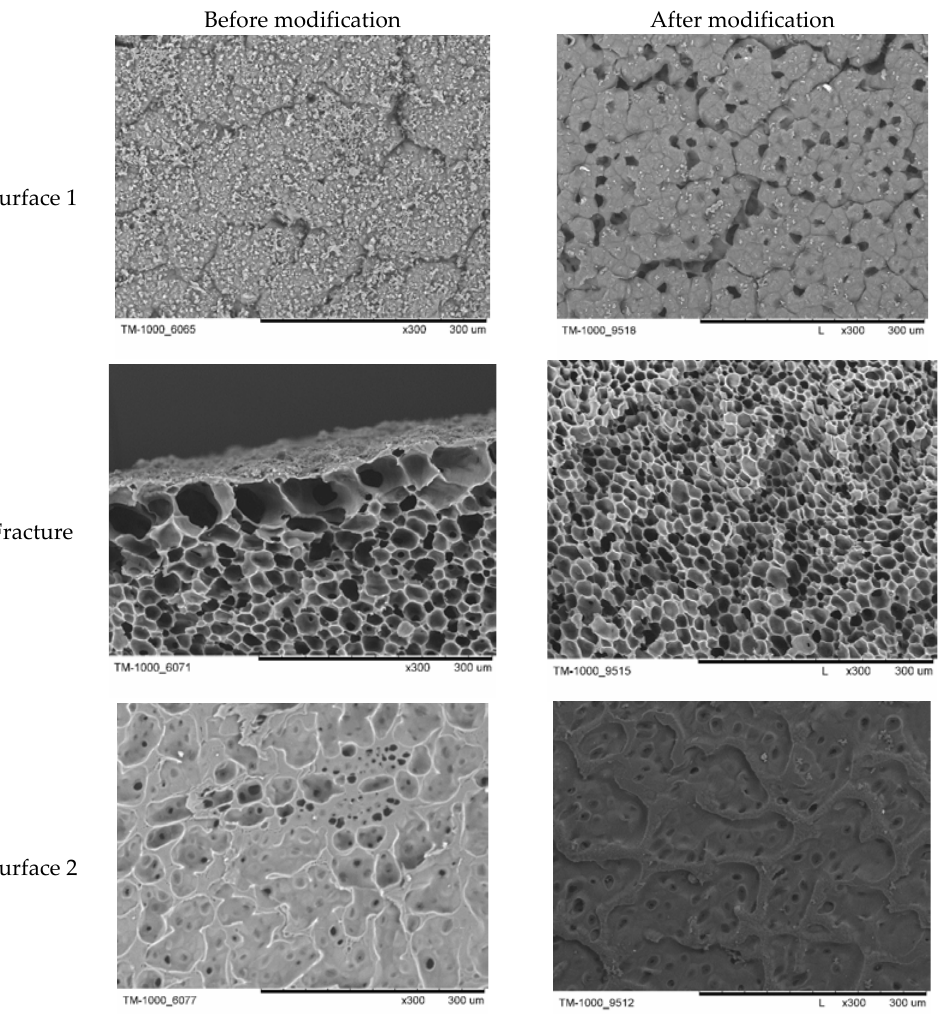
Figure 6. The morphology of Membrane I (MI) obtained before and after plasma modification. Based on the obtained SEM images of the PLA membrane MII (Figure 7), it was found that S1 contained many more pores than S2. After the plasma modification, the area of the pores increased, suggesting a slight melting of the membrane surface. In the fracture of the sample, more pores were close to the membrane surface, and the surface itself has numerous large depressions. That could increase the capillary forces, reducing the water contact angle of the surface. This modification is very beneficial considering the use of the membranes for medical purposes, as it would simplify the penetration of liquid into the membrane. The fractures of the unmodified membrane and the membrane after modification looked similar, and slight differences may have been a result of the fact that they were two separate samples. S2 before and after modification was almost solid, and the use of barrier discharge plasma slightly smoothed